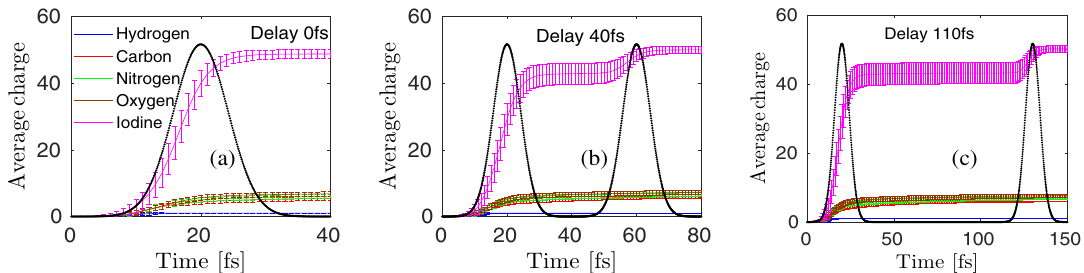
Figure 1. Average charge as a function of time, representing (a) 0fs delay, where the two pulses are coincident, (b) 80fs delay and (c) 110fs delay. The black curve represents the temporal Gaussian envelope of 10 fs FWHM. The fluence considered is 1.0 × 10 13 ph /µ m 2 , whereas the average charge is calculated using 50 trajectories for each delay.